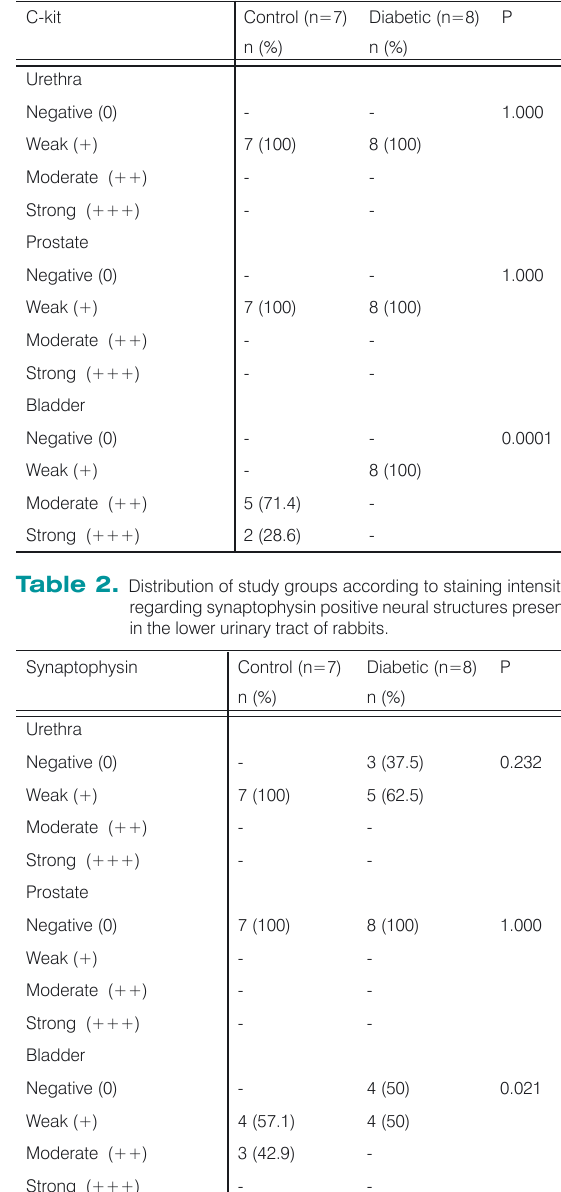
Figure 1. Weak (+) c-kit expression of ICs in (a) normal urethra in the control group and (b) in prostate of rabbits with diabetes (CD117, DAB, x100). ICs: Interstitial cells.